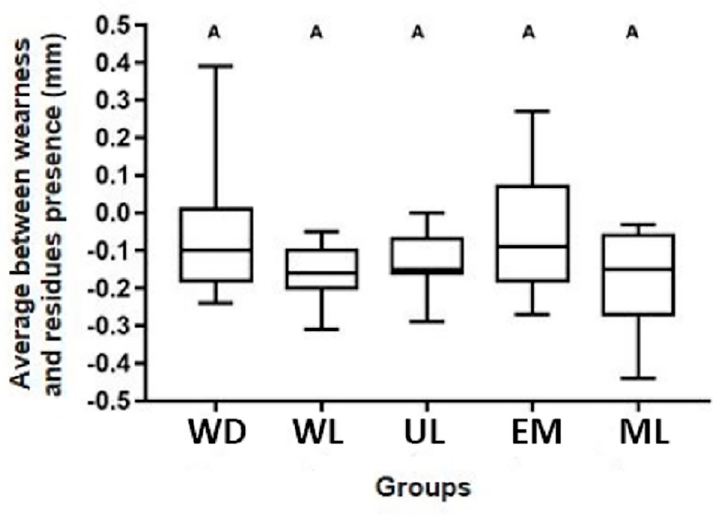
Fig 6. Box plots of the average considering dental wear and resin residues areas (mm 2 ) between T2 and T1 for each